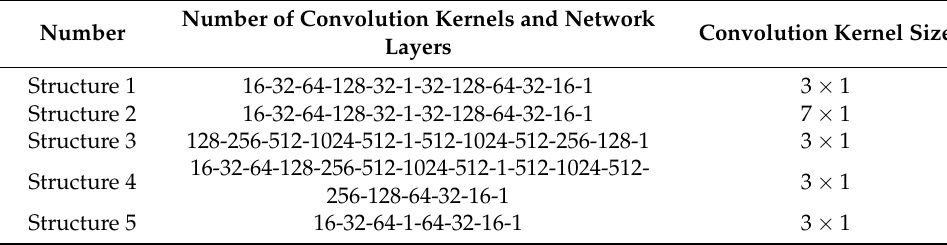
Table 3. The five structures of the DCAE.